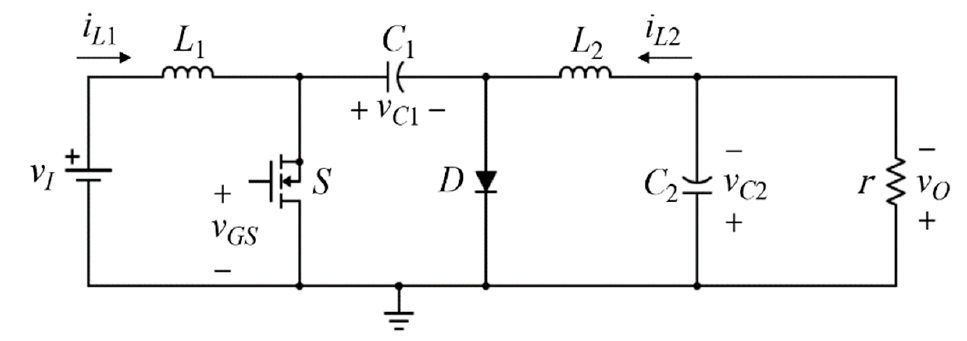
Figure 1. DC-DC Cuk converter circuit.